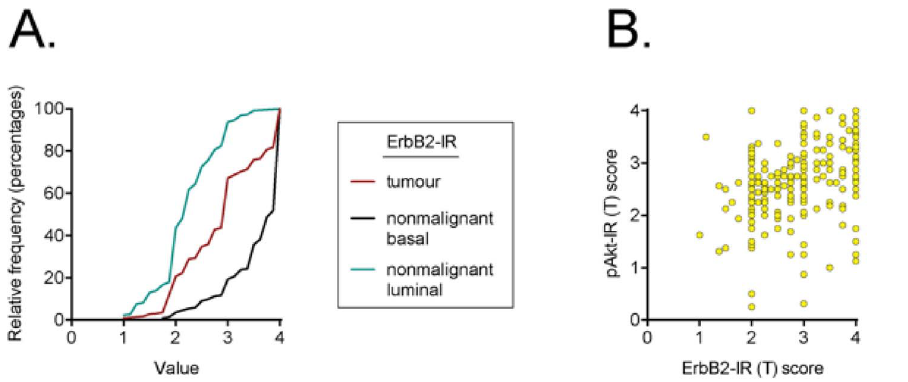
Figure 2. ErbB2 immunoreactivity in Pca tissue microarrays. In Panel A the cumulative frequencies of ErbB2-IR scores are shown for the tumour samples (n=357), and for the basal and luminal nonmalignant samples (n=222 in both cases). The median values (with interquartile range in